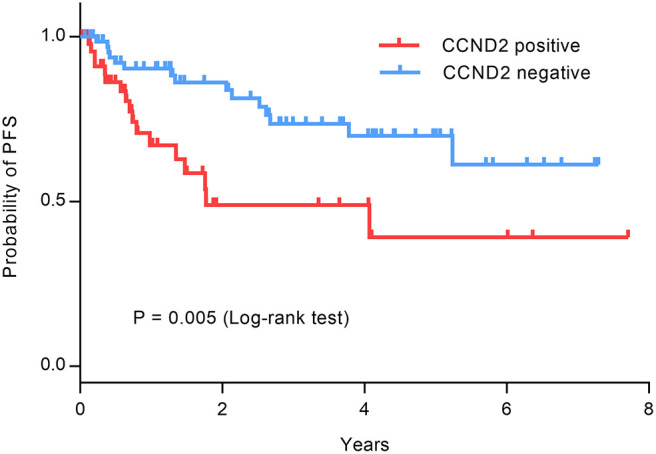
Survival curves of patients with ABC-DLBCL positive (n = 47; red line) and negative (n = 68; blue line) for CCND2 mRNA expression.